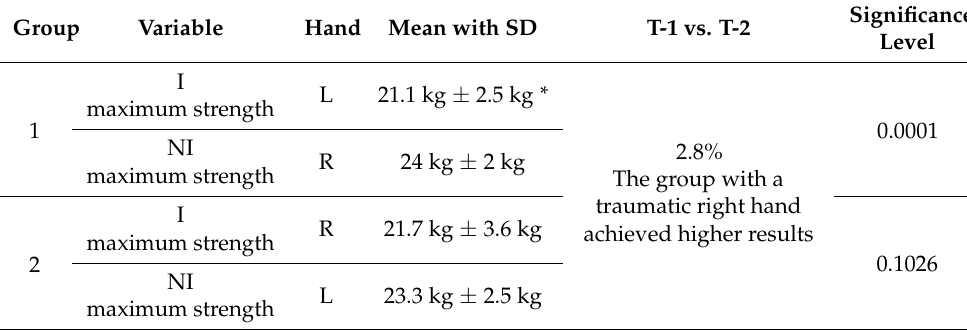
Table 8. Comparison of results for maximum strength.